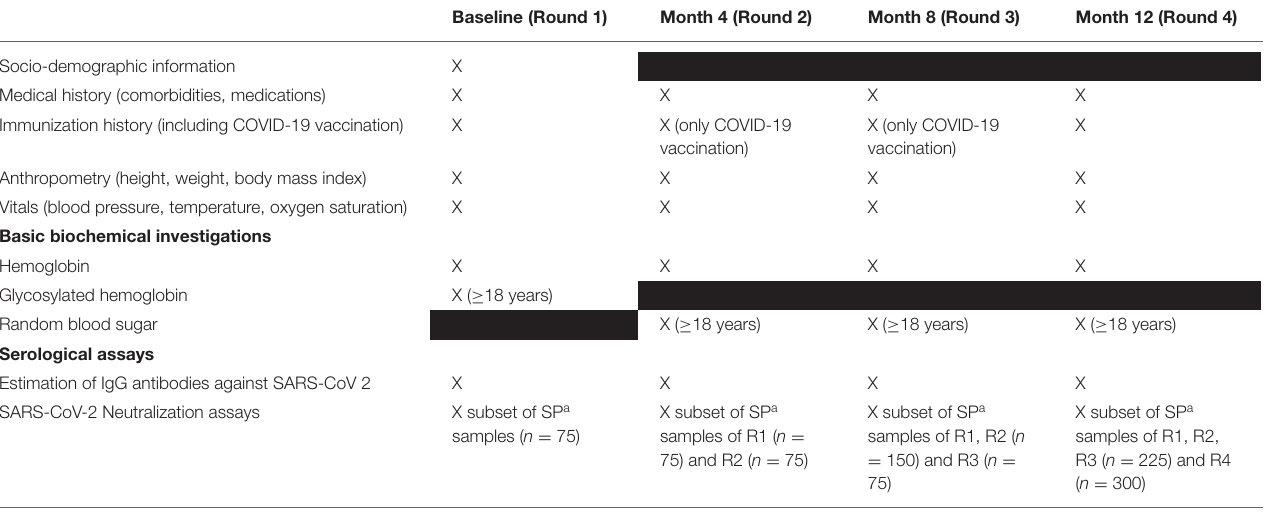
TABLE 2 | Key data points and investigations for